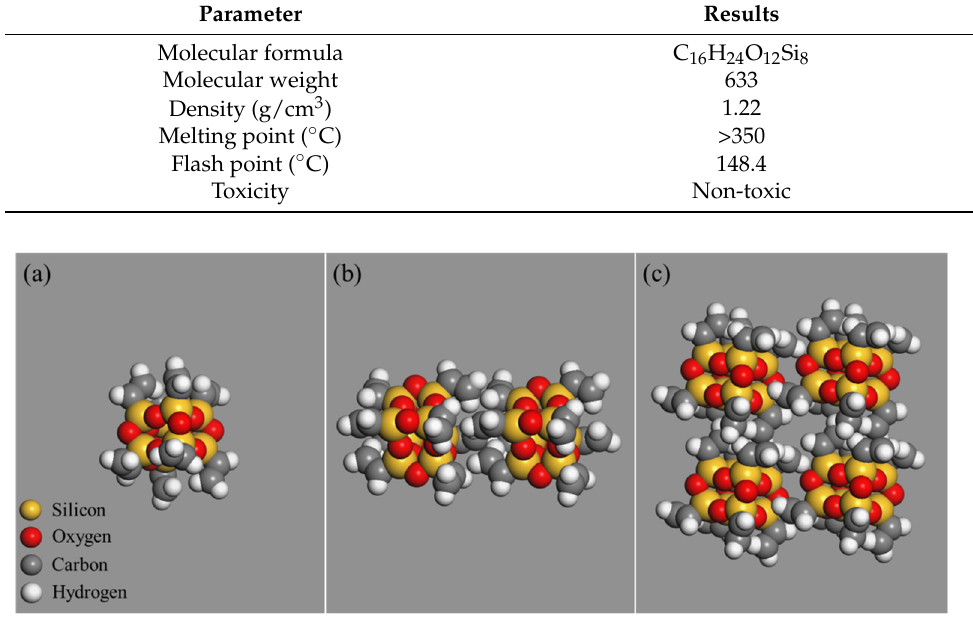
Figure 2. OvPOSS nanoclusters with different sizes: ( a ) 5 Å; ( b ) 7 Å; ( c ) 9 Å (silicon atoms are orange and oxygen atoms are red).